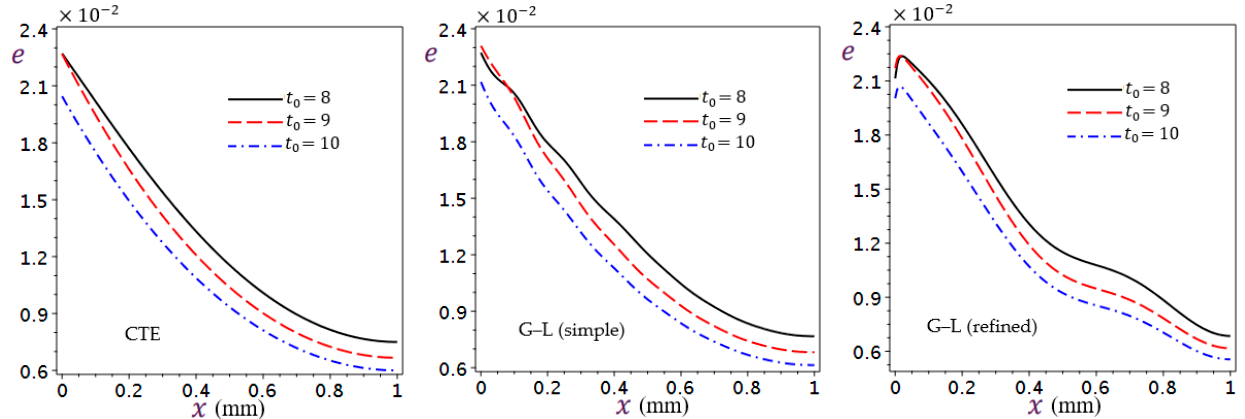
Figure 8. Effect of ramp-type heating parameter t 0 on dilatation e .